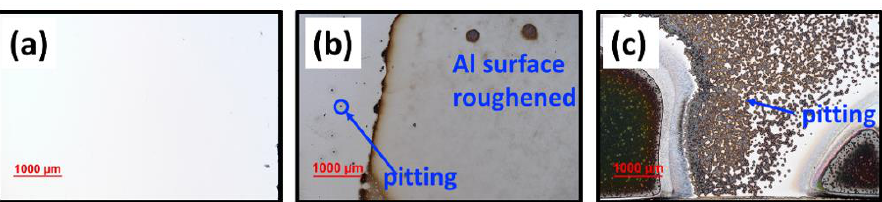
Figure 2. Corrosion screening of blanket Al samples. ( a ) As prepared before immersion. ( b ) Immersed